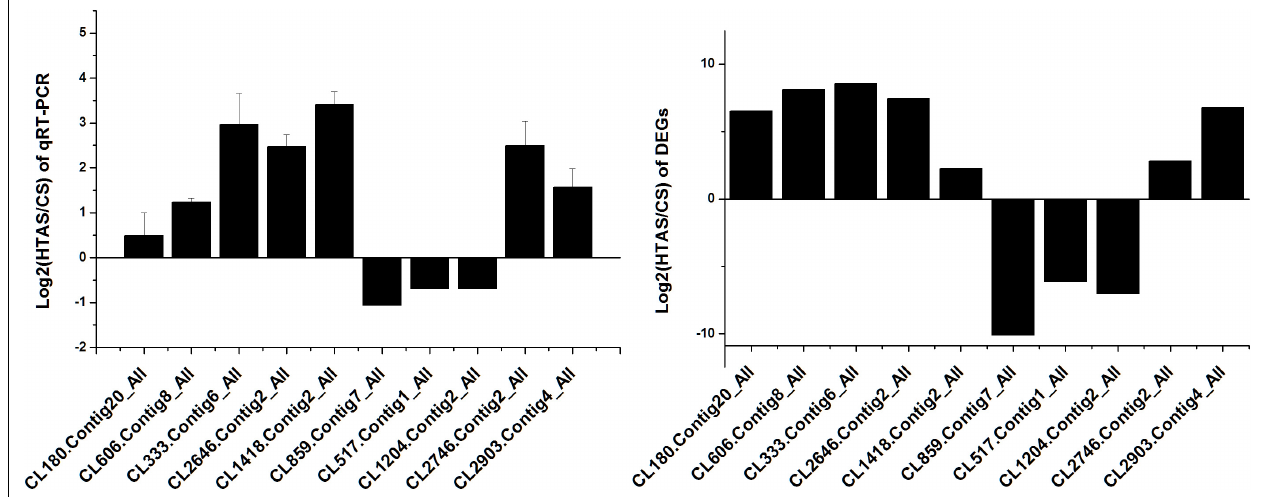
FIGURE 8 | qRT-PCR analysis of the expression levels of 10 Unigenes. X axis represents different Unigenes. CL333.Contig6_All, fructose-2,6-bisphosphatase; CL2646.Contig2_All, calcium-binding protein; CL2903.Contig4_All, mucolipin; CL180.Contig20_All, single-stranded DNA-binding protein; CL606.Contig8_All, stromal interaction molecule; CL859.Contig7_All, DNA polymerase; CL517.Contig1_All, RING finger and SPRY domain-containing protein; CL1204.Contig2_All, long-chain fatty acid; CL1418.Contig2_All, HSP70 and CL2746.Contig2_All, HSP20. Y axis represents the relative expression levels of